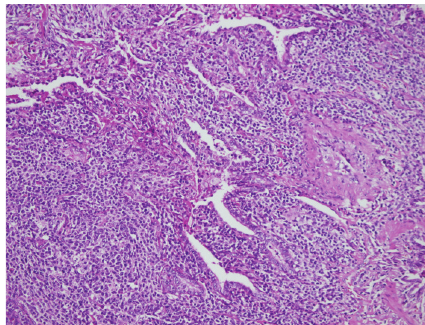
Figure 2: The lymphocytes infiltrated bronchiolar epithelium form- ing well-defined lymphoepithelial lesions. Scattered germinal cen- ters were present throughout (hematoxylin-eosin staining, × 200).